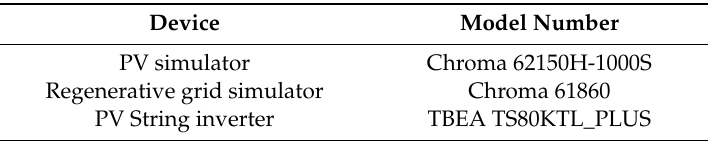
Table 3. Model number of devices used in the experiment.